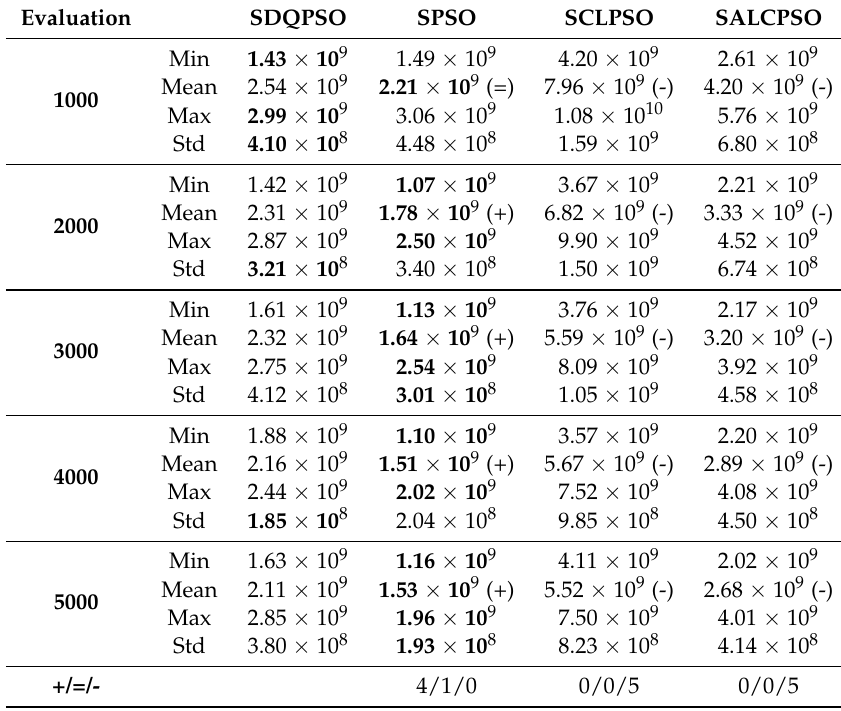
Table 5. Optimization performance under different function